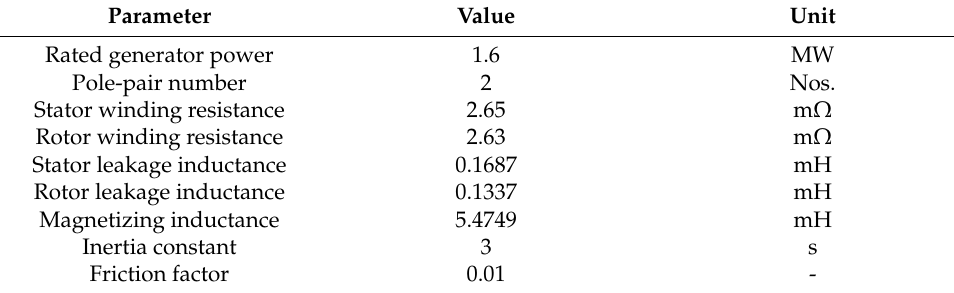
Table A2. Parameter of 1.6 MW DFIG.